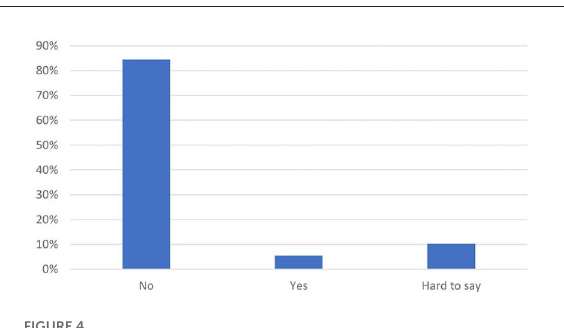
FIGURE3 Have you been appreciated by your employer? ( N = 294).